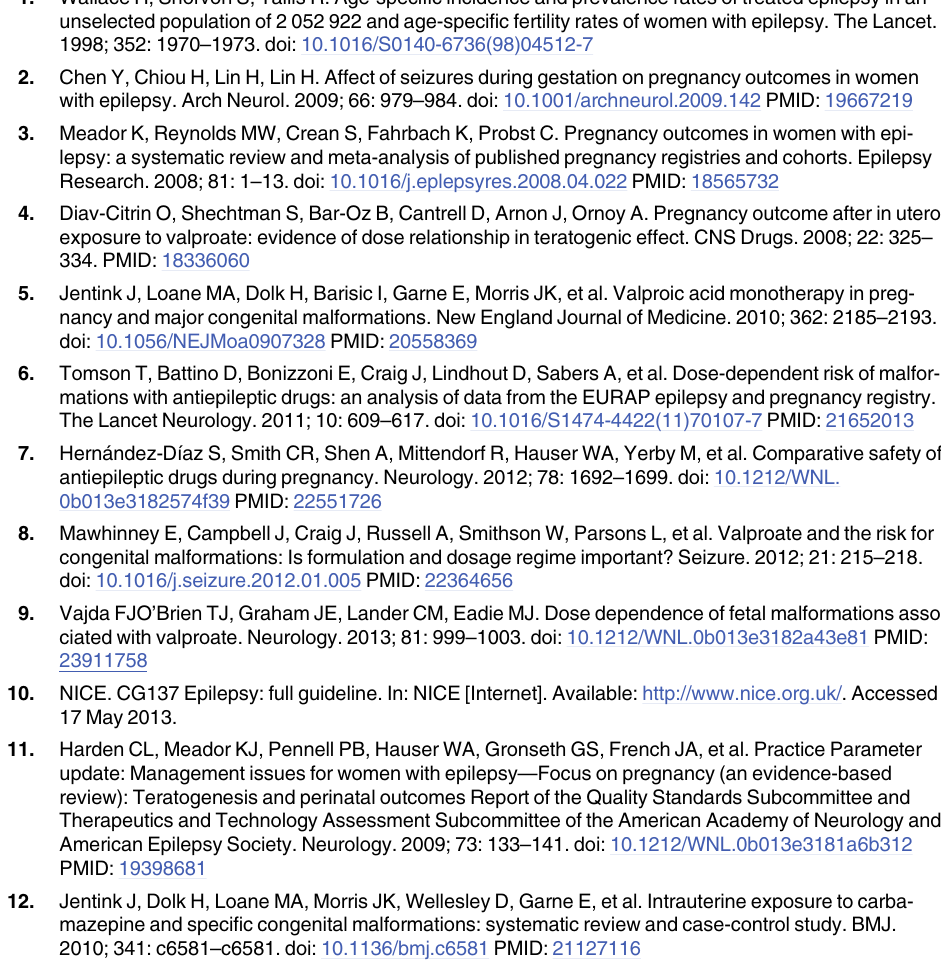
S3 Table. Sensitivity analysis of individual antiepileptic drug types prescribed as monother- apy only: Adjusted odds ratios for the association of major congenital anomalies with anti- epileptic drugs in the 1 st trimester of pregnancy (cid:1)